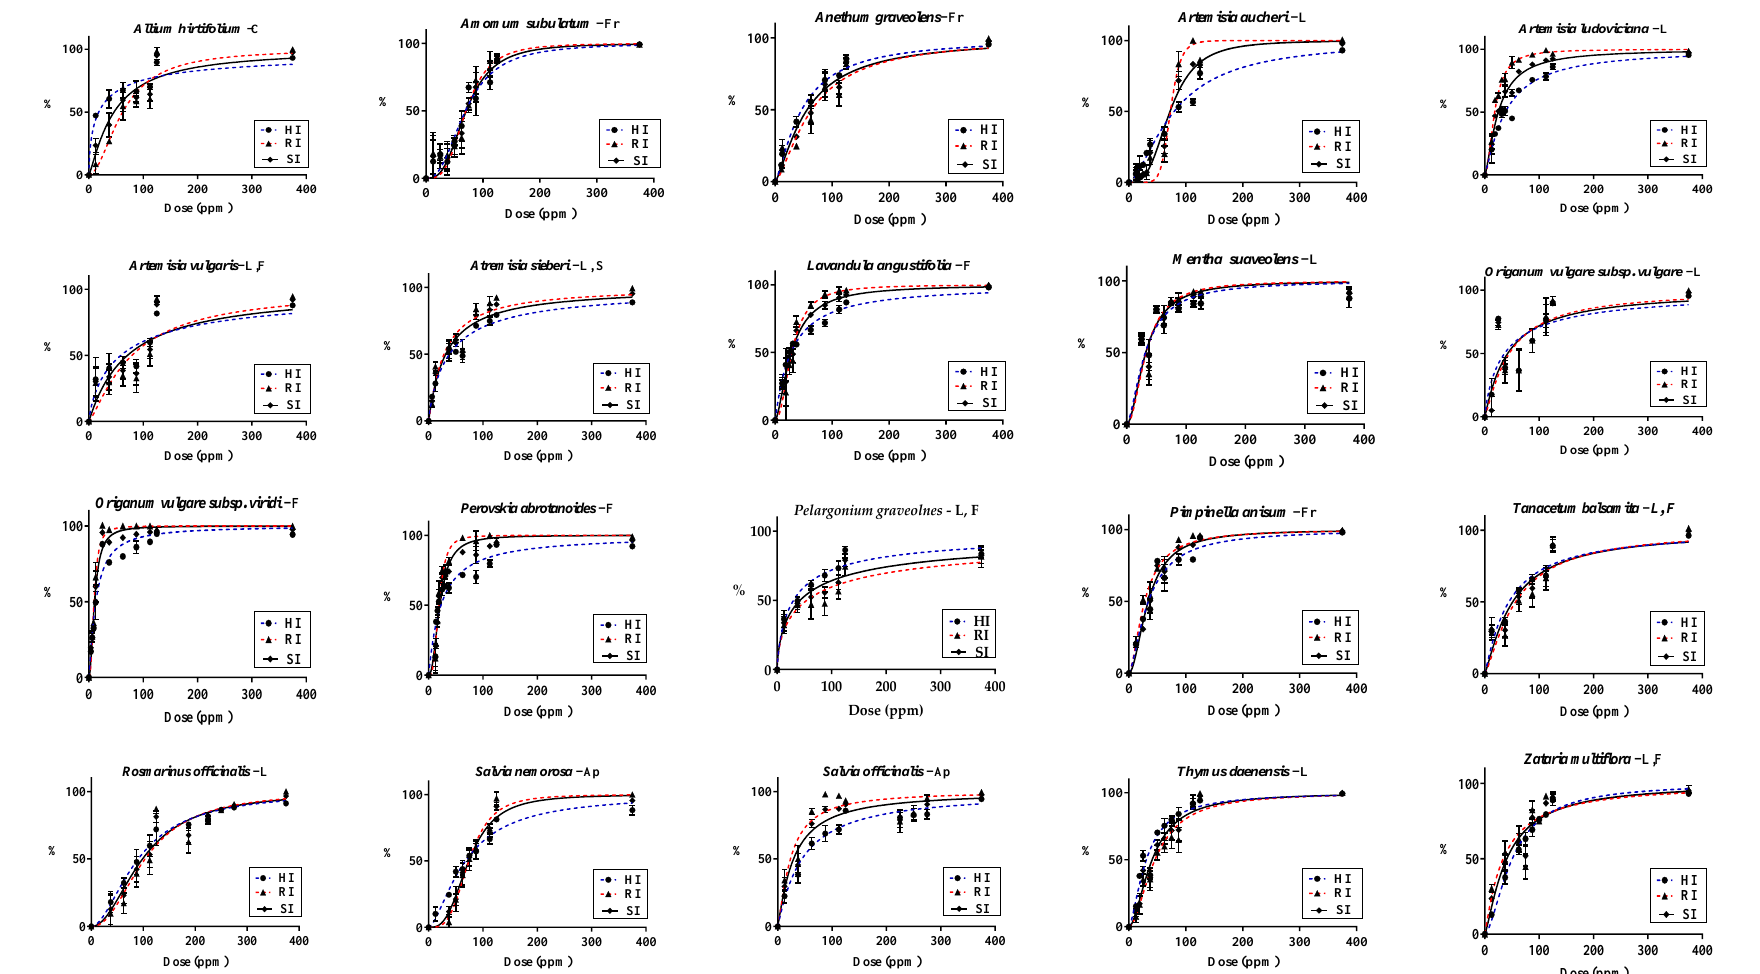
Figure 5. Dose–response diagrams of lettuce seedling growth affected by 20 EOs in cotton swab method. HI: Hypocotyl Inhibition, RI: Radicle Inhibition, SI: Seedling Inhibition.